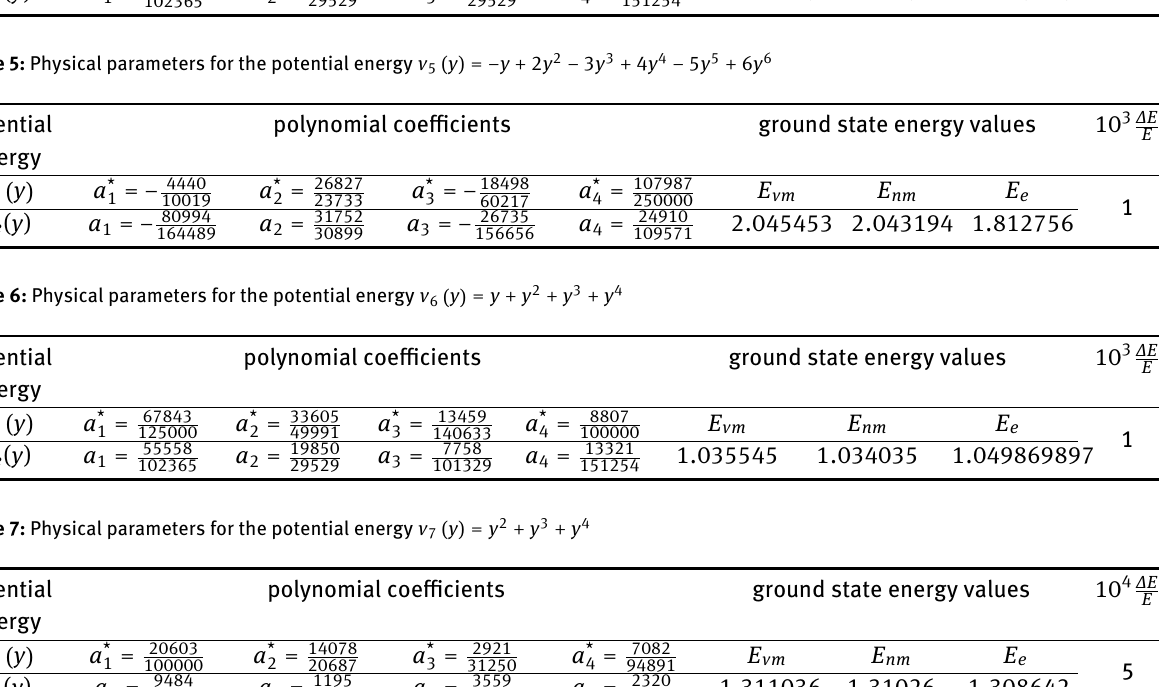
potential energy